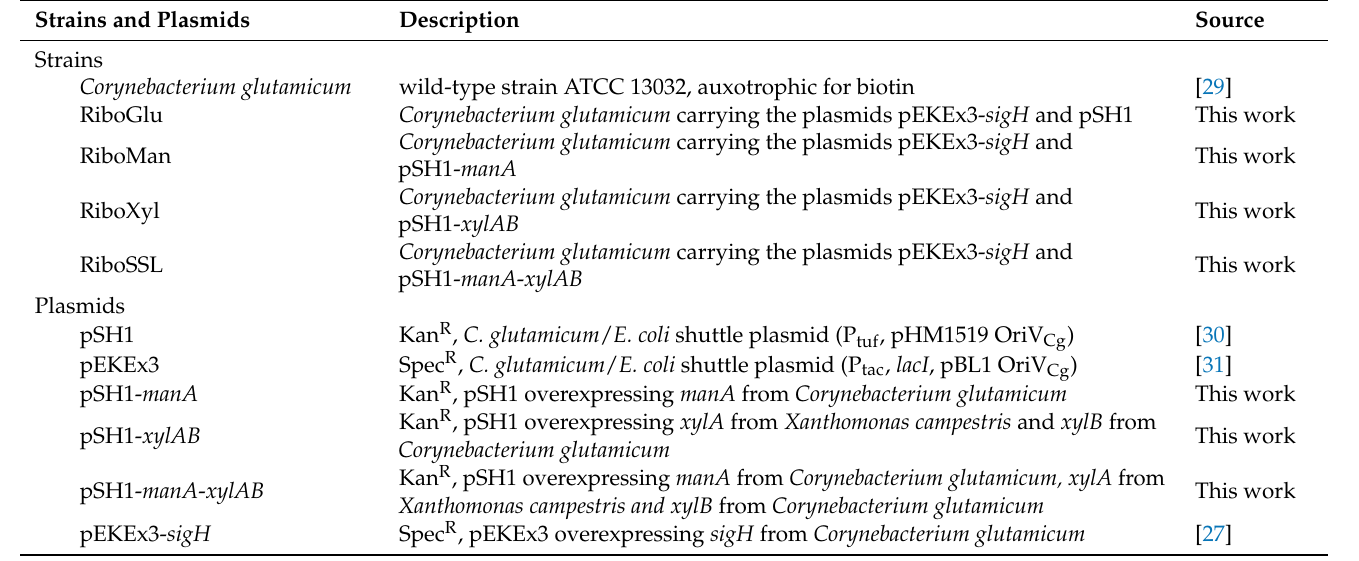
Table 1. Strains and plasmids used in this